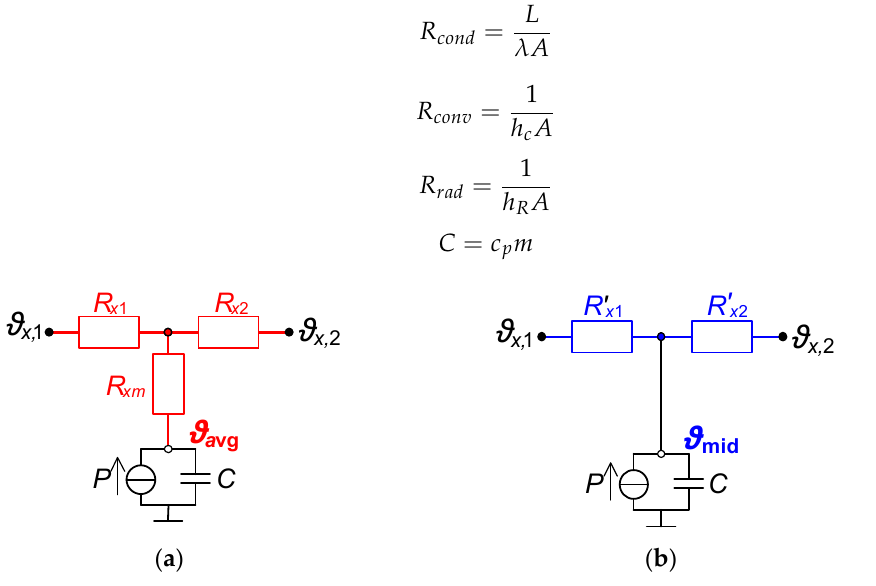
Figure 17. Elementary thermal networks. ( a ) “T-type”. ( b )